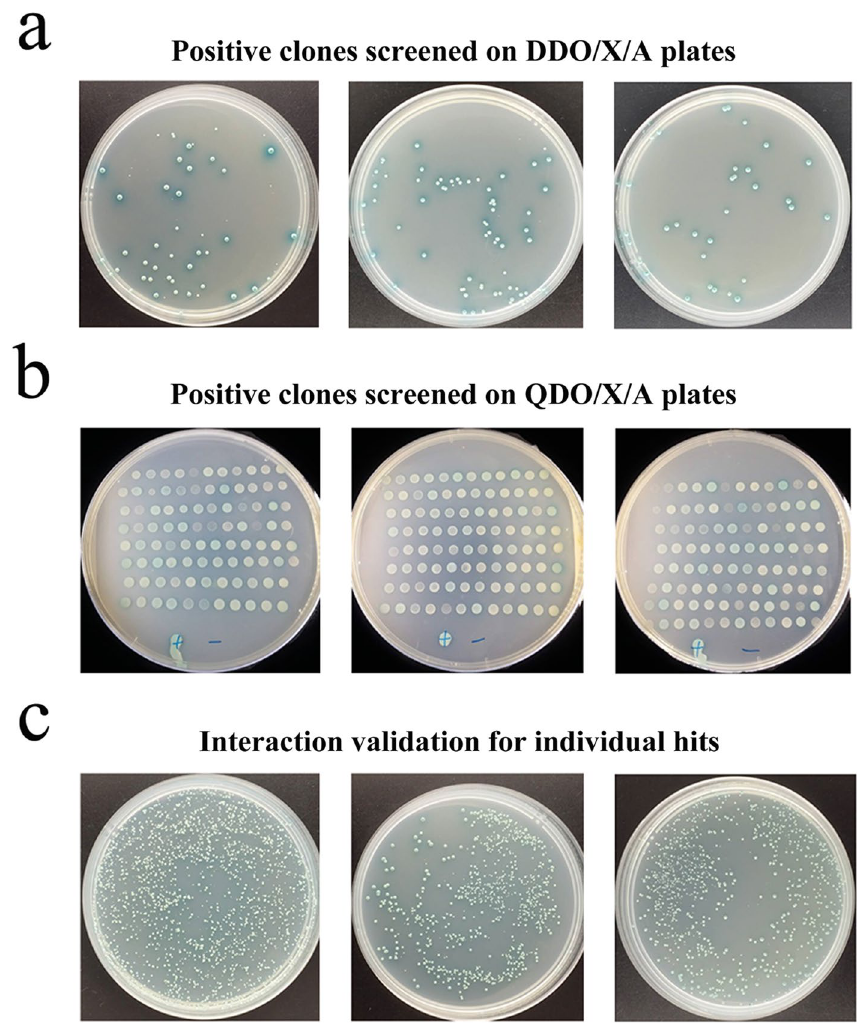
Figure 3. Screening and identification of putative interacting proteins in C. chloroleuca 67-1 via Y2H. ( a ) Positive clones screened on DDO/X/A plates. ( b ) Positive clones screened on QDO/X/A plates. “+” represents the positive control; “−” represents the negative control. ( c ) Interaction validation for individual hits. pGBKT7- 53 and pGADT7-T plasmids were co-transformed into Y2H Gold cells as a positive control, while the